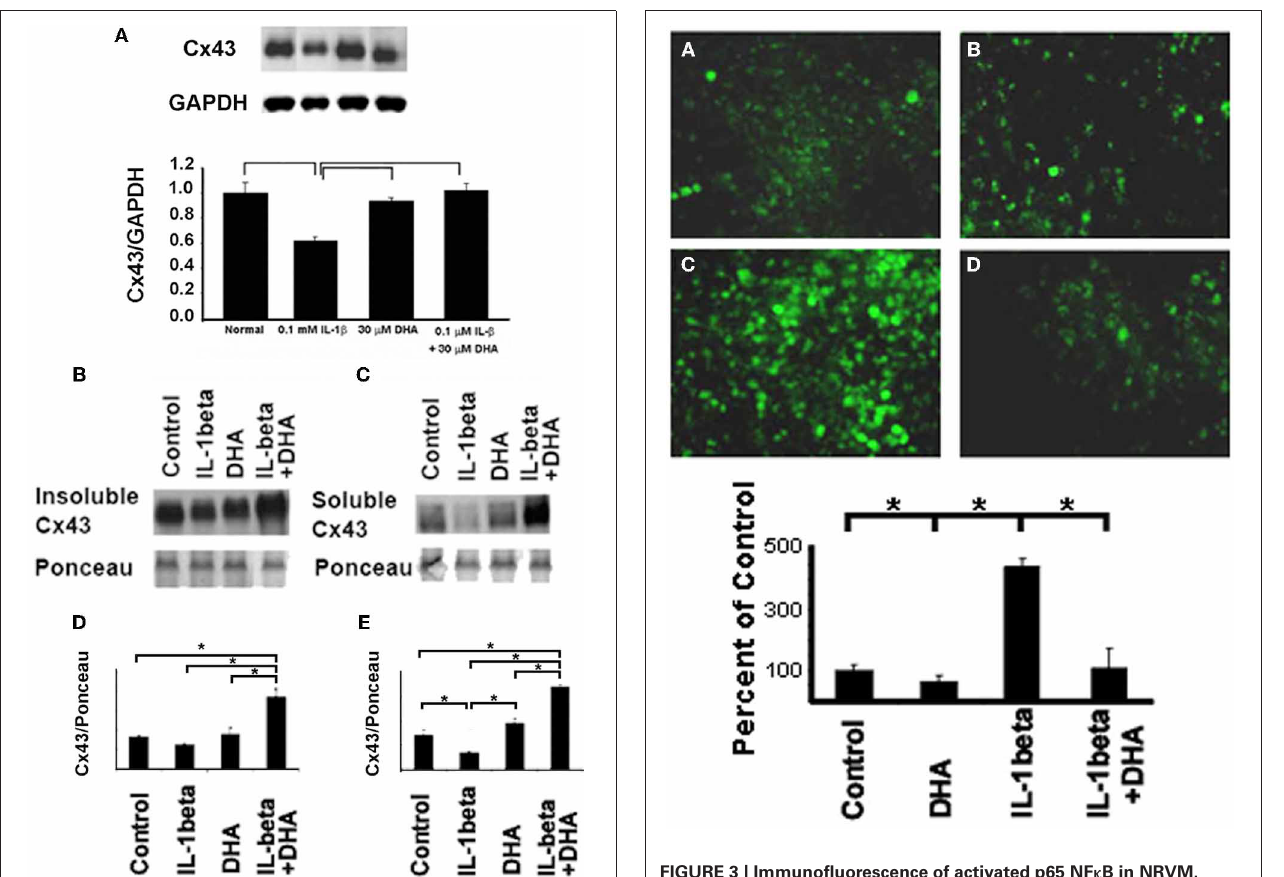
FIGURE 3 | Immunofluorescence of activated p65 NF κ B in NRVM. Control cells show low levels of NF κ B staining (A) which is not change with DHA incubation alone (B) . In contrast, stimulation with IL-1 β led to significant increases in NF κ B activation (C) . DHA incubation inhibited activation of NF κ B back to control levels (D) . ( n = 3, p < 0 .